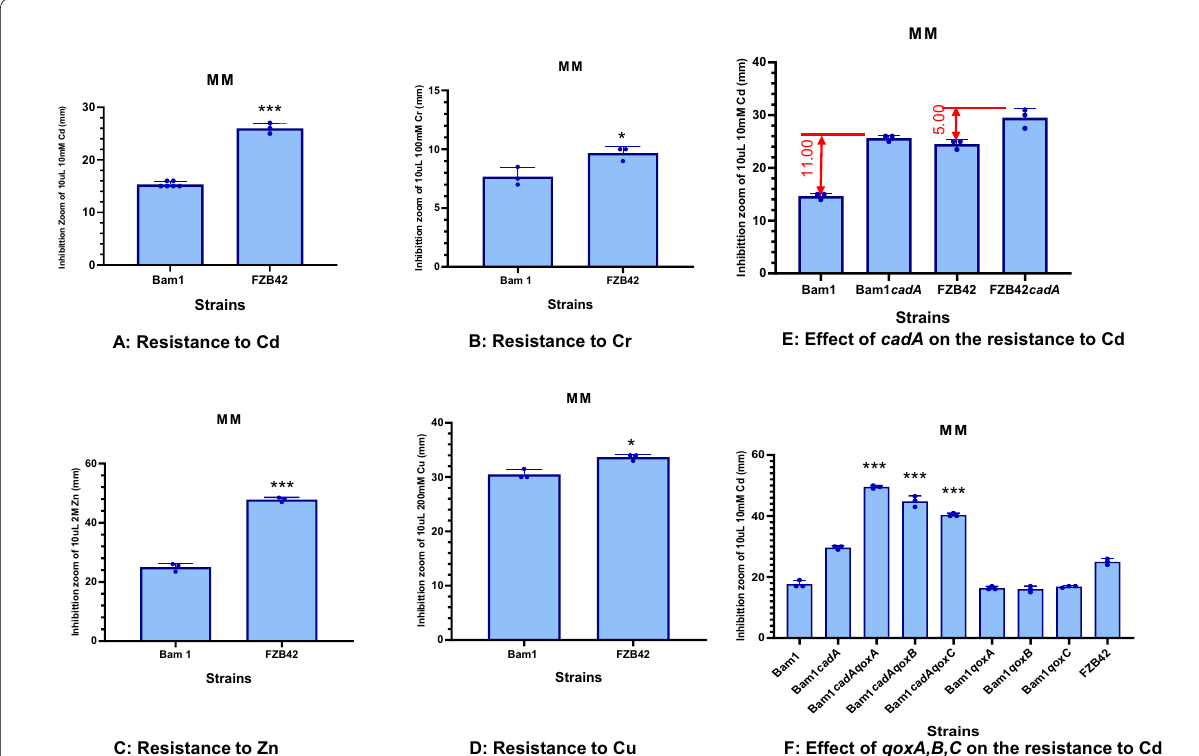
Fig. 7 Resistances of B. amyloliquefaciens strain Bam1, B. velezensis FZB42 and their mutants to different heavy metals. All measurements are mean SEM ( n 3). *** represents significant difference ( P < 0.01), * represents significant difference ( P < ± =